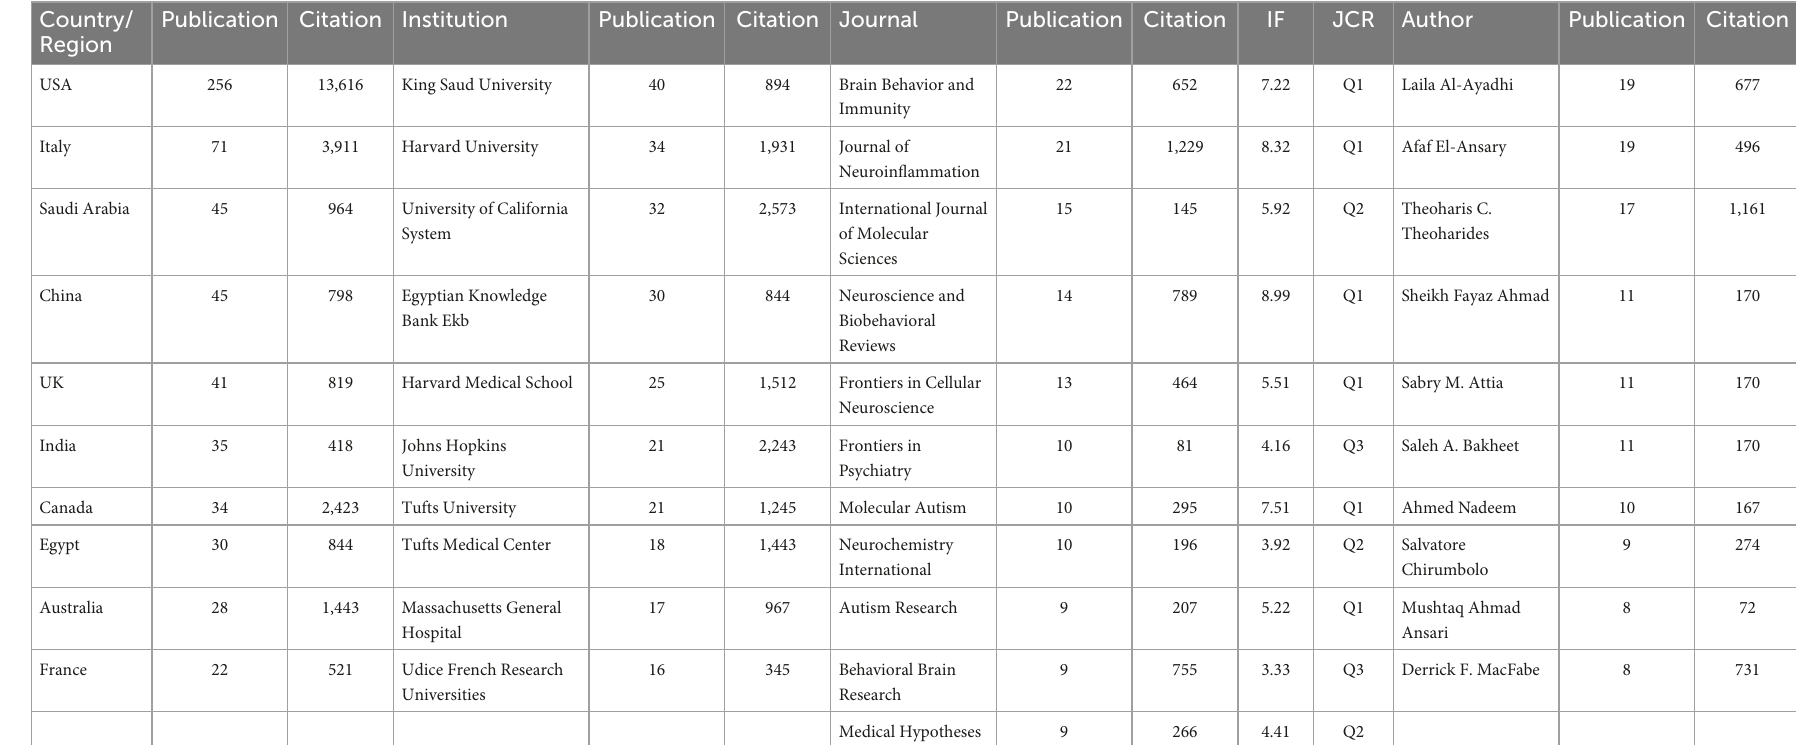
TABLE 1 Top 10 countries, institutions, journals, and authors. Country/